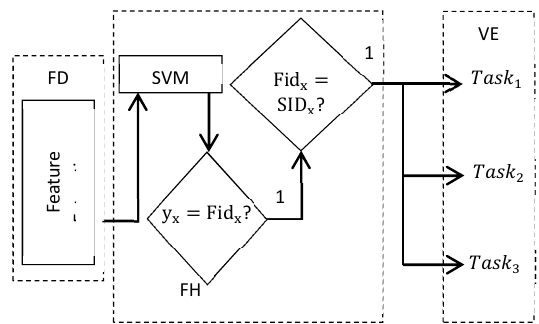
Fig. 9: Identifying an Interaction from a known Fist- Posture 3.7 Interactions by the Movements of Thumb The basic VR interactions; translation, selection, scaling and navigation are performed by the perceptive movements of thumb. At an attained state SID S position of the